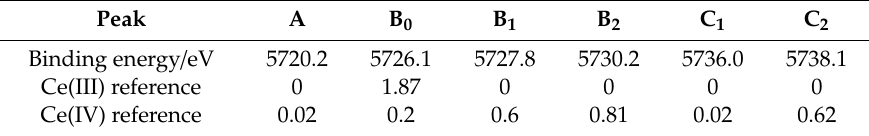
Table 1. Overview of the individual contributions (peak heights and energy of Lorentzian) to the normalized XANES spectra of our references at the Ce L III absorption edge, with the peaks and peak positions taken from [45]. The respective initial and final states are discussed in that reference. Peak A B 0 B 1 B 2 C 1 C 2 Binding energy / eV 5720.2 5726.1 5727.8 5730.2 5736.0 5738.1 Ce(III) reference 0 1.87 0 0 0 0 Ce(IV) reference 0.02 0.2 0.6 0.81 0.02